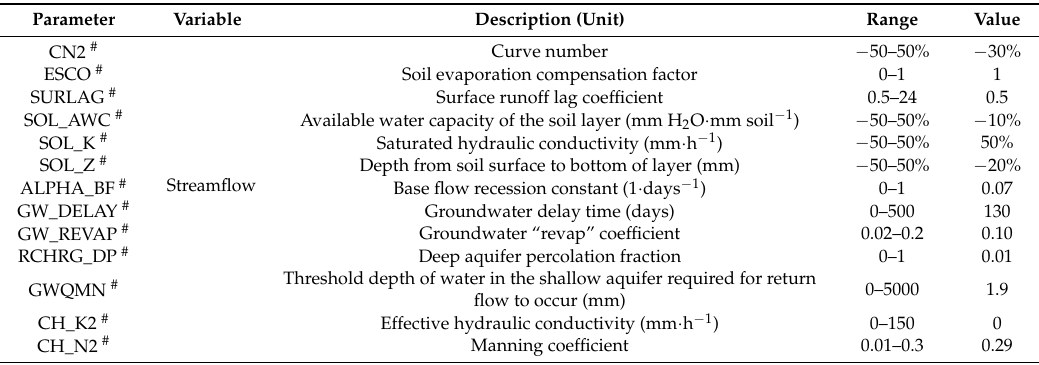
Table 3. List of calibrated